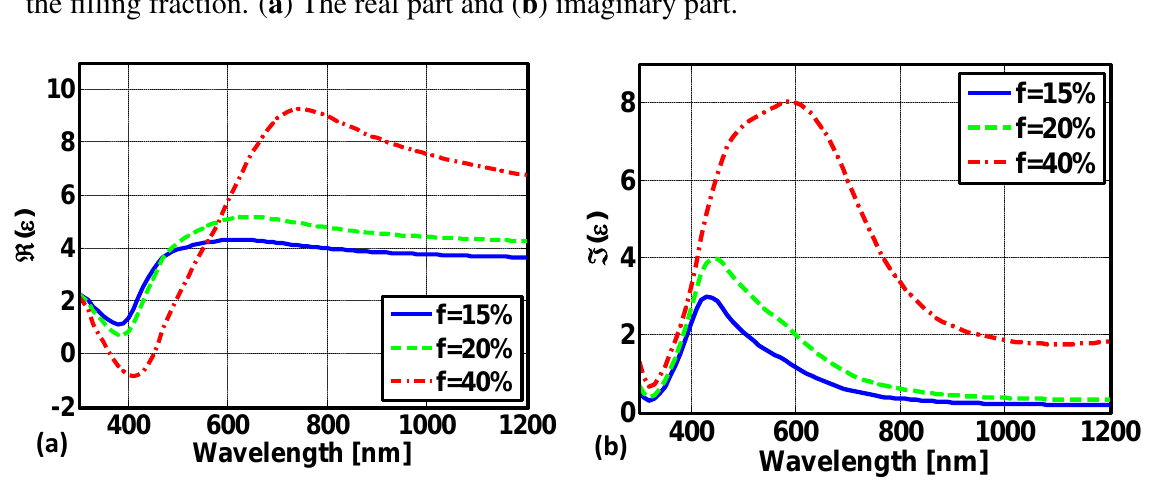
Figure 4. Rigorously calculated effective properties of a silver nanocomposite depending on the filling fraction. ( a ) The real part and ( b ) imaginary